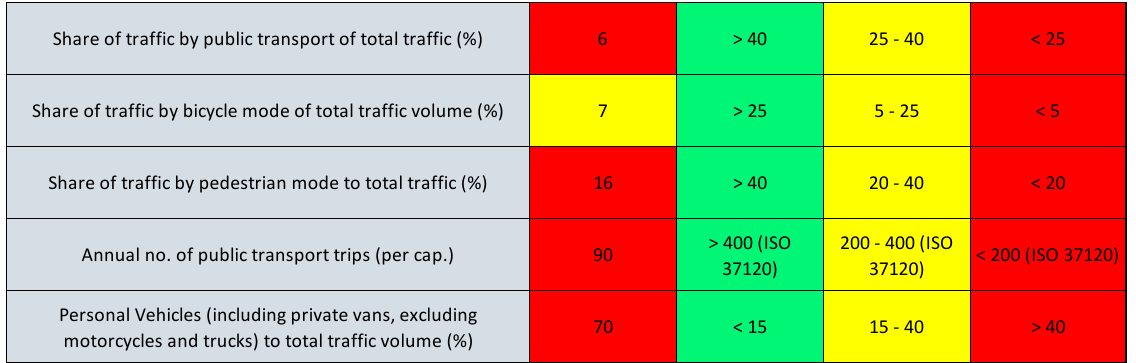
Figure A3. Sample of assessed mobility indicators adapted for the project from